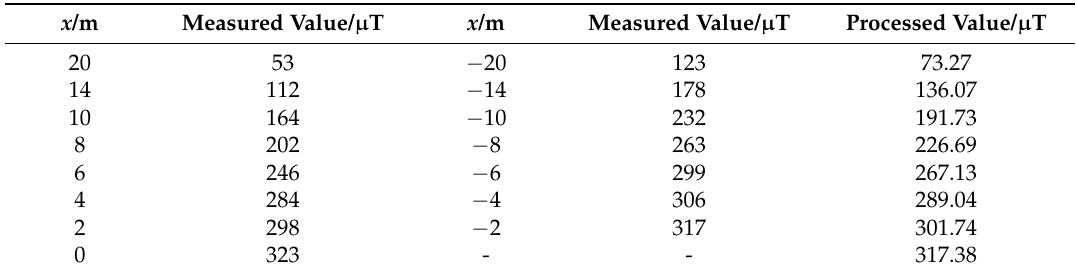
Table 2. Measured value and processed value.